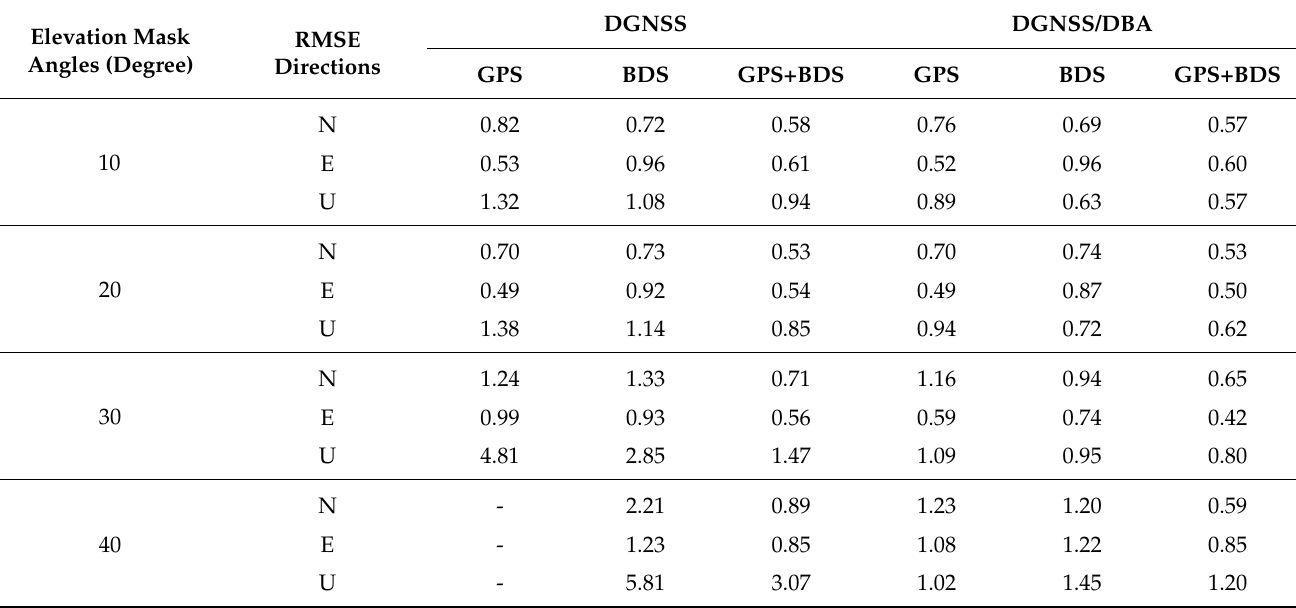
Table 4. The RMSE values of the two data processing modes in the N/E/U directions at different elevation mask